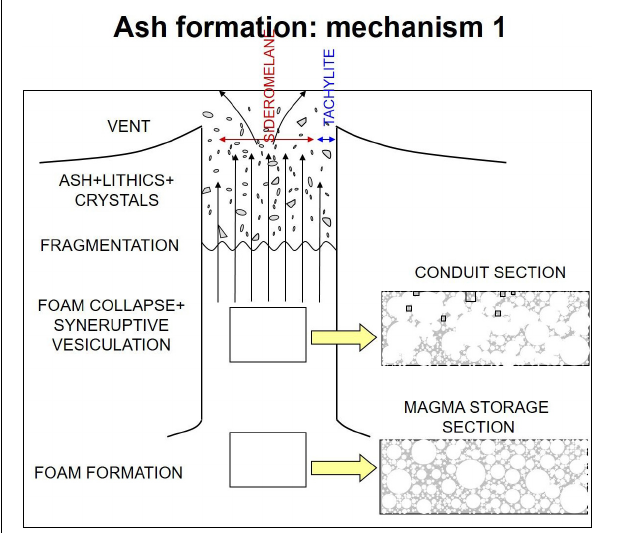
FIGURE 7 | Sketch of ash formation by fragmentation of vesiculating magma (mechanism no. 1). Grey areas in conduit section and in magma storage section insets indicate liquid magma (plus crystals). Not to scale. See text for further explanation.